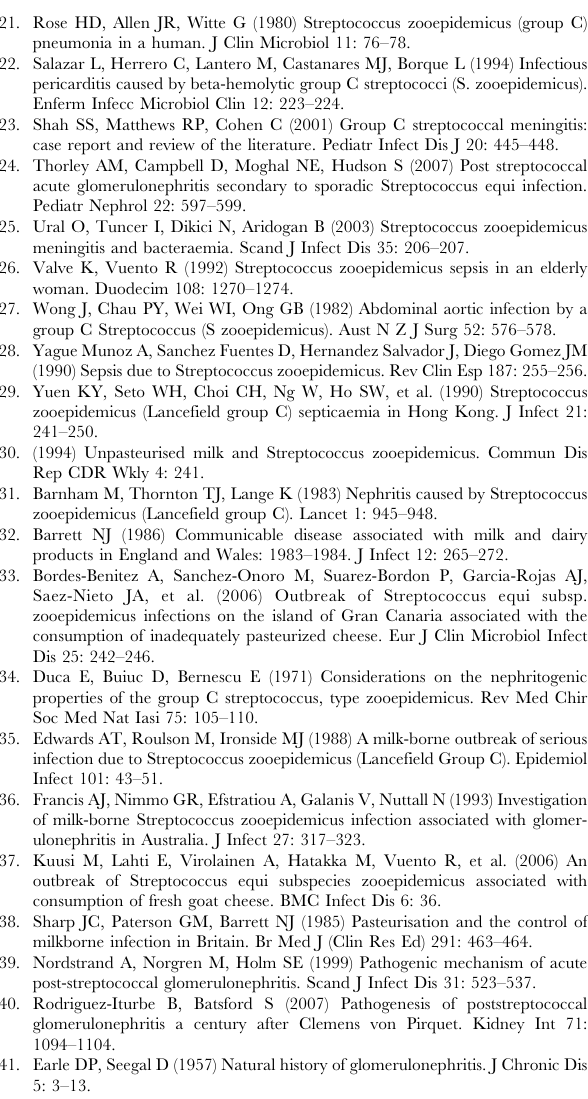
Table S1 Products with Predicted Sec-Dependent Secretion Signal Sequence. Inferred proteins with canonical amino-terminal Sec-dependent secretion signal sequence Table S2 Products with Predicted Lipidation Signal Sequence. Inferred lipoproteins with with canonical amino-terminal lipida- tion signal sequence